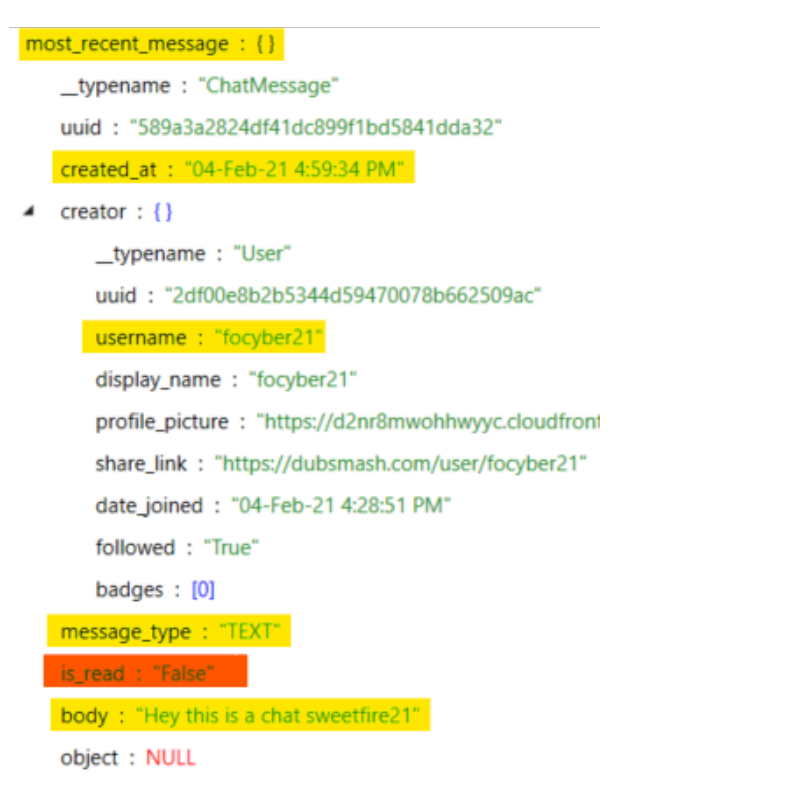
Figure 13. First chat the Android account received from the iOS account, as recovered from the Dubsmash app on Android.